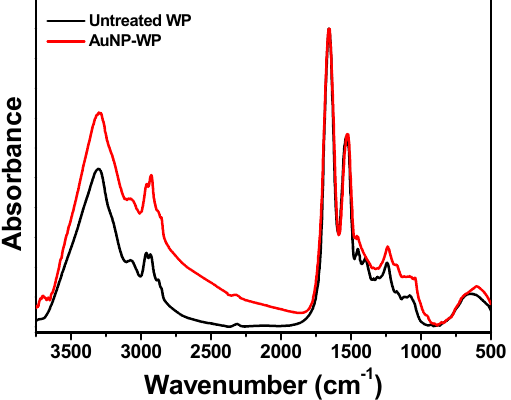
Figure 9. Normalized FTIR spectra of untreated wool powder and AuNP-WP from 0.06 mM of Au ions.